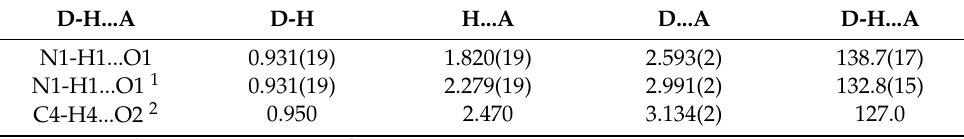
Figure 3. Hydrogen bond contacts ( upper ) and molecular packing ( lower ) via hydrogen bonding interactions for 1 . The molecular units in the crystal lattice are packed by two intermolecular hydrogen bonding interactions shown as red dotted lines in Figure 3 (upper part). The corresponding hydrogen bond parameters are listed in Table 1. The packed molecules via the N1-H1...O1 and C4-H4...O2 hydrogen bonding interactions with donor-acceptor distances of 2.991(2) and 3.134(2) Å, respectively are shown in Figure 3 (lower part). Table 1. Hydrogen bond parameters (Å and ◦ ) for 1